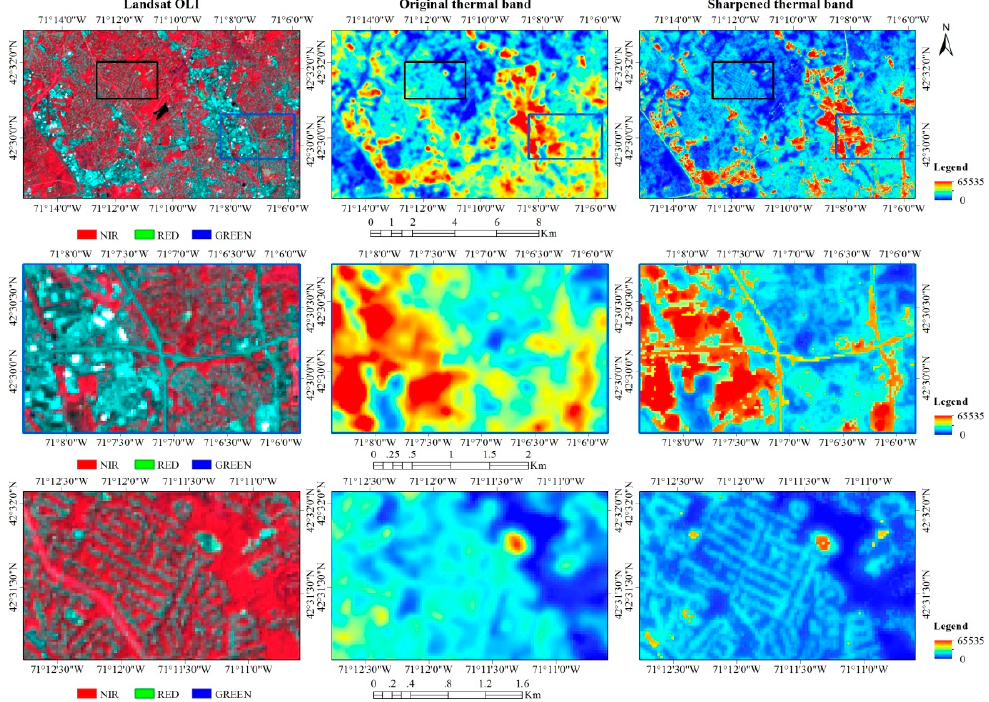
Figure 5. Sharpening of the OLI-TIRS image acquired on 13 July 2016: the first column is the standard false color display; the second column represents the original thermal band; and the last column denotes the sharpened thermal band. Two example subsets are shown in the second and third lines of each column.